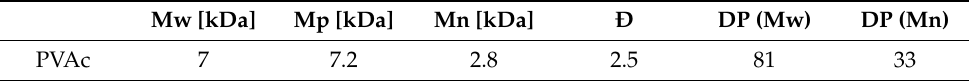
Table 1. Molecular weight characteristics of PVAc, as analyzed by